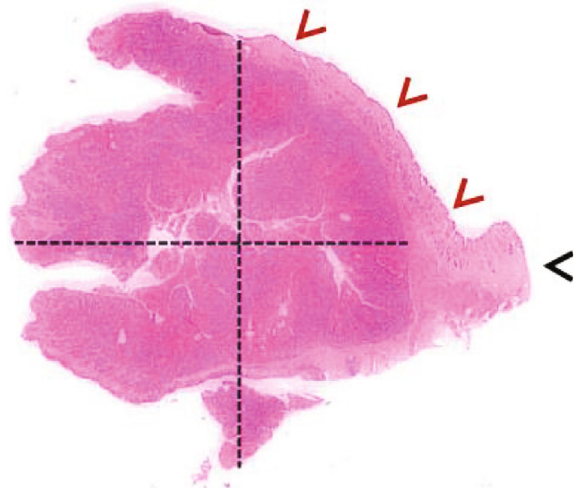
Figure 4: Oral lesion. Scanning of the entire slide. This picture clearly shows that the neoplasm was very extensive in both width and depth (black dotted lines). The lesion widely in fi ltrated the lip thickness, excluding only a thin layer of skin (red head arrows) and the lip border (black head